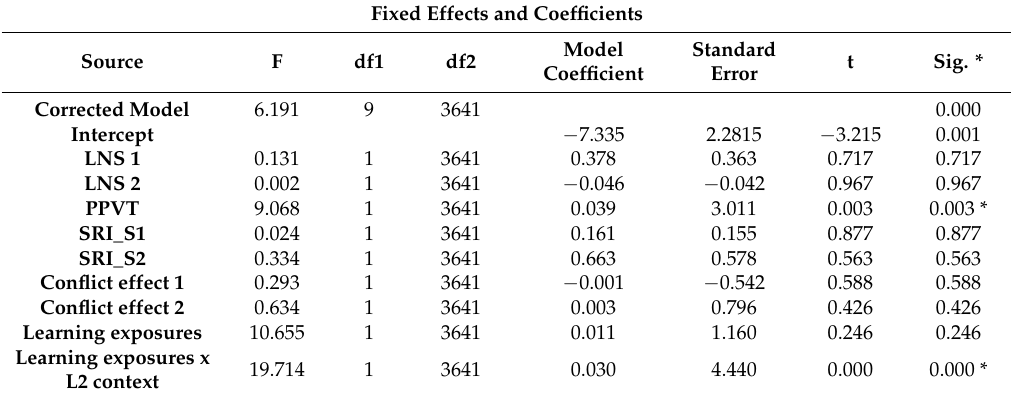
Table 5. Overview of individual difference results from binomial logistic regression across all